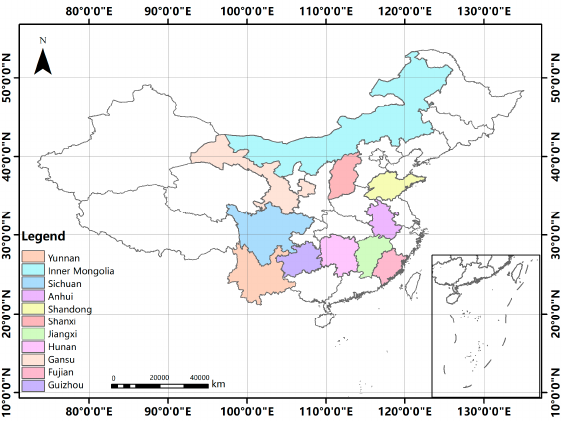
Figure 1. Distribution areas for model establishment and testing data for different tree species.